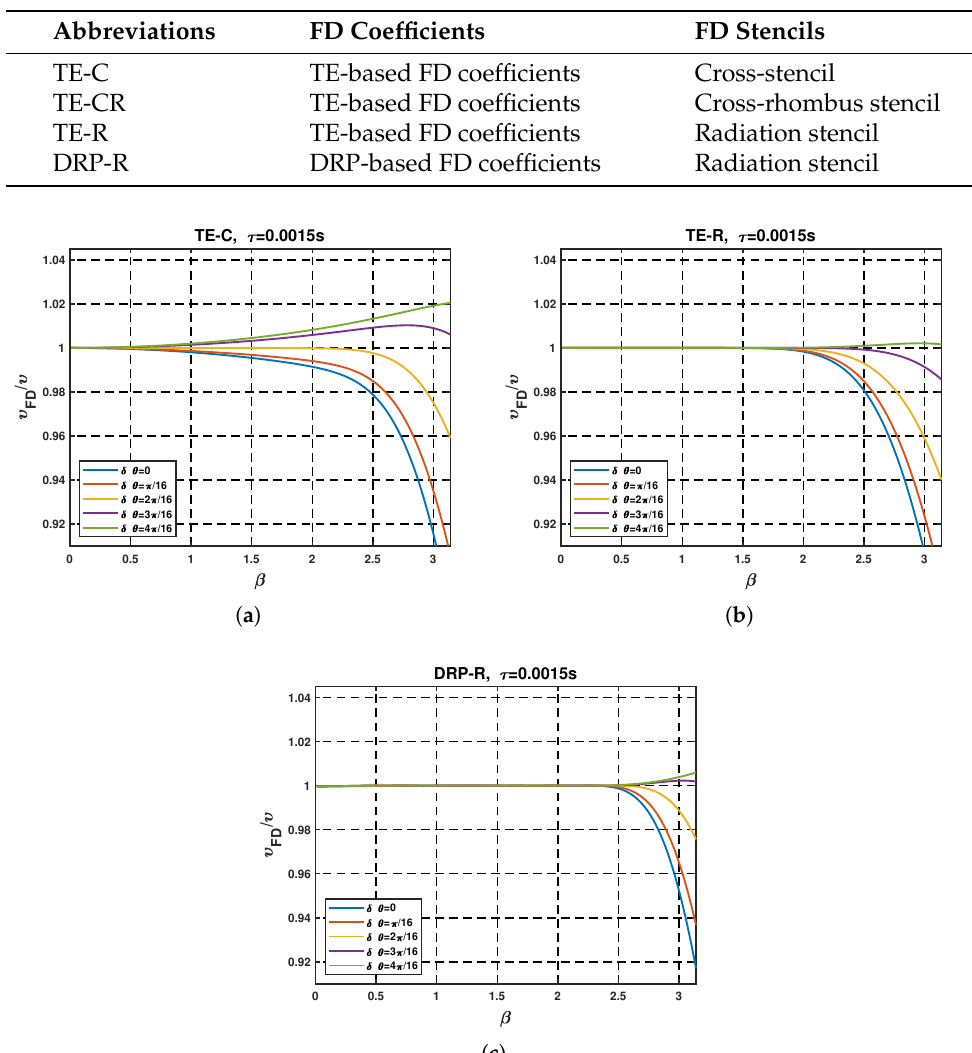
Table 1. Abbreviation table of different FD methods used for dispersion analyses.